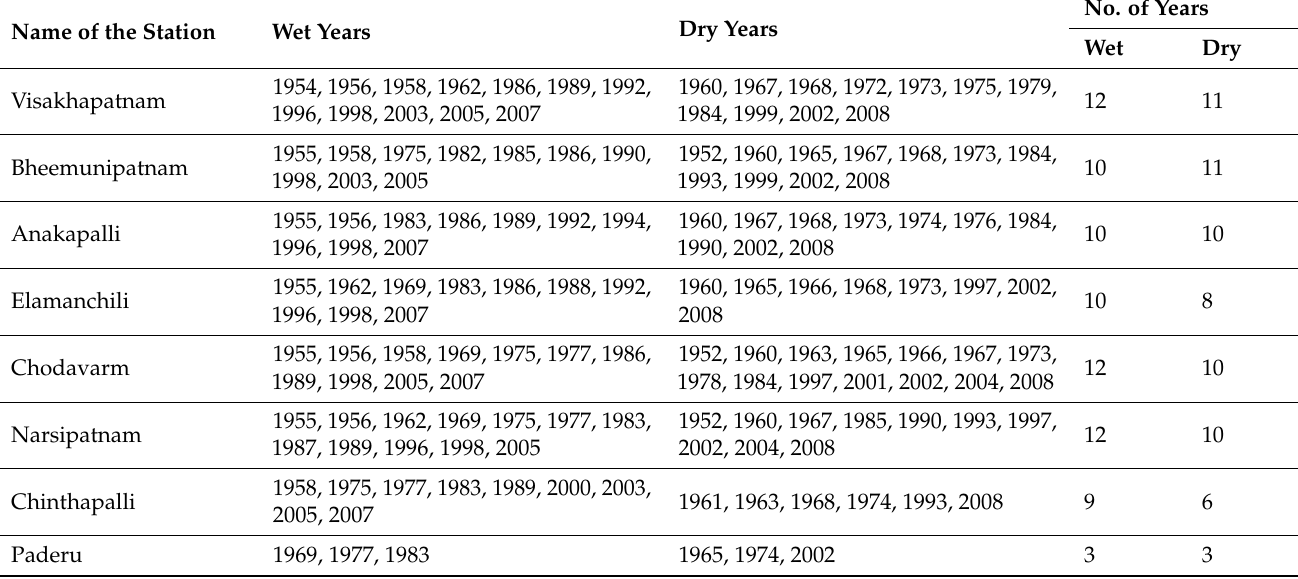
Table 1. Visakhapatnam district wet and dry years